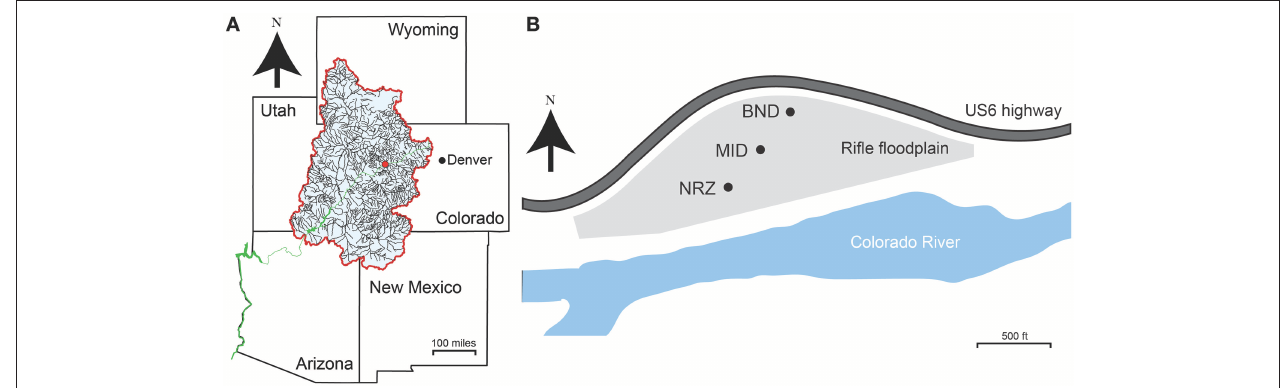
FIGURE 1 | (A) Site location (red dot) in the context of the upper Colorado River basin (blue shaded area). The Colorado River is shown in green. (B) Locations of the three sampling wells across the Rifle aquifer used in this study. CMT01 (BND) and CMT02 (MID) are separated by ∼ 100m, while CMT02 (MID) and CMT03 (NRZ) are separated by ∼